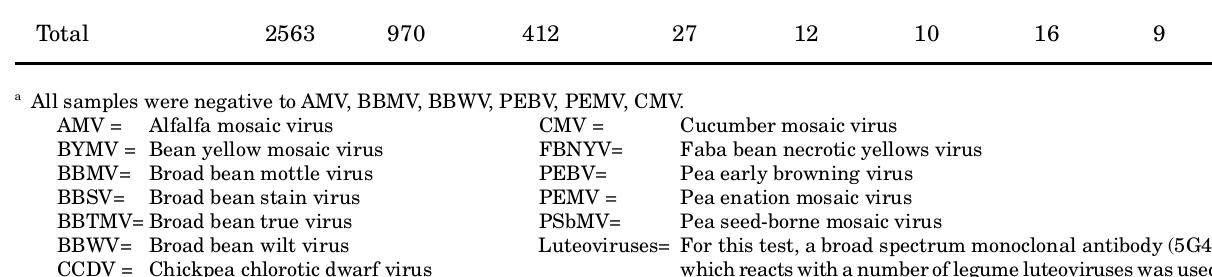
North Shewa 306 West Shewa